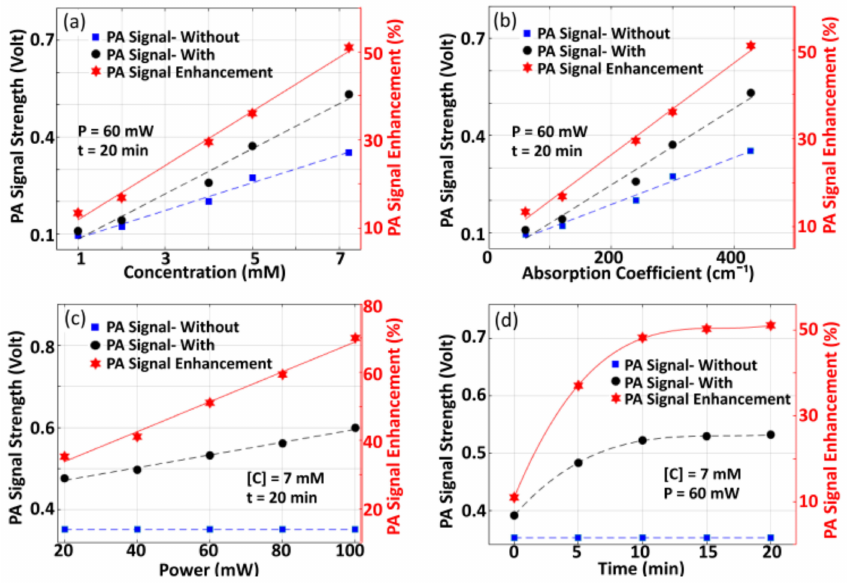
( enh ) with concentration ([ C ]) of sample solution. In the 0 ( enh ) with optical absorption 0 ( enh ) with optical 0 ( enh ) with 0